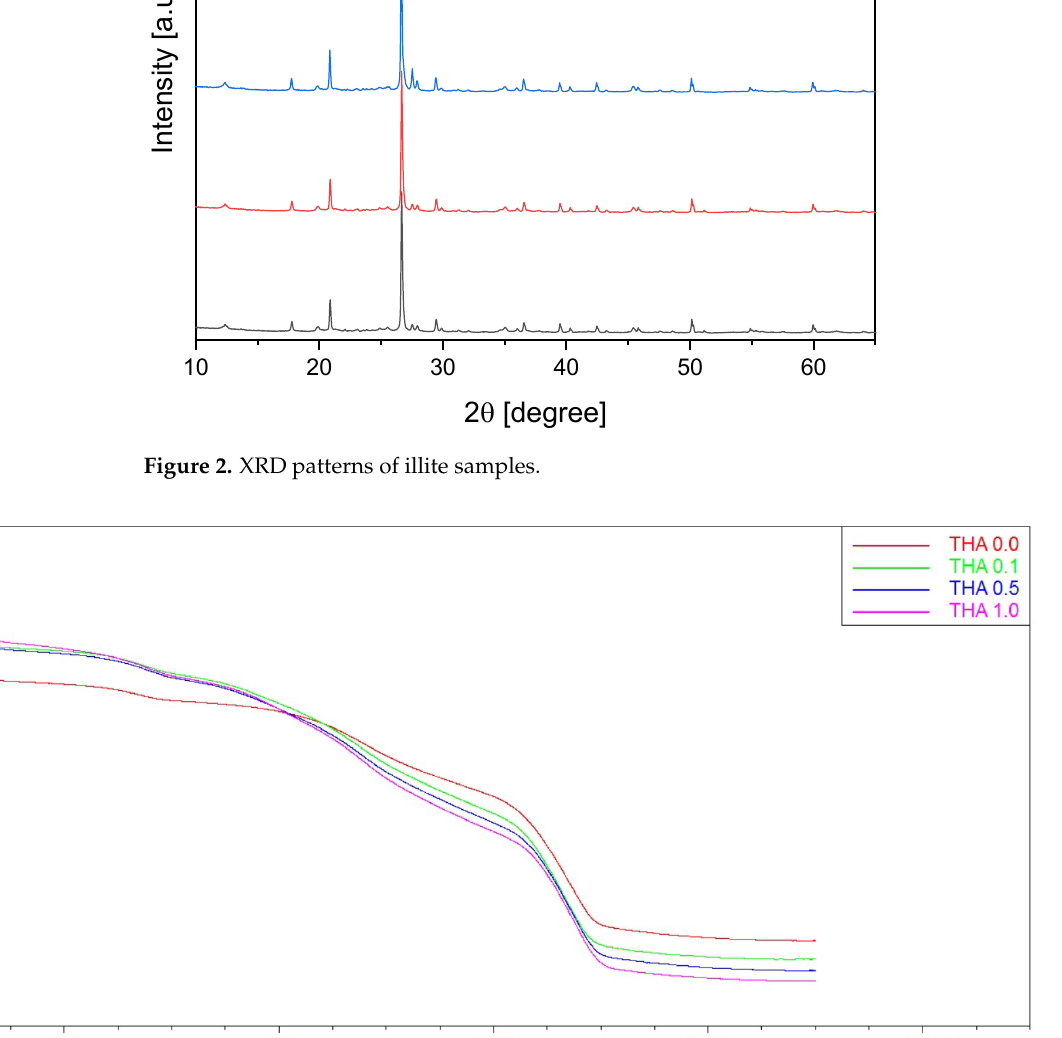
Figure 3. TGA diagrams of pure and modified illite .